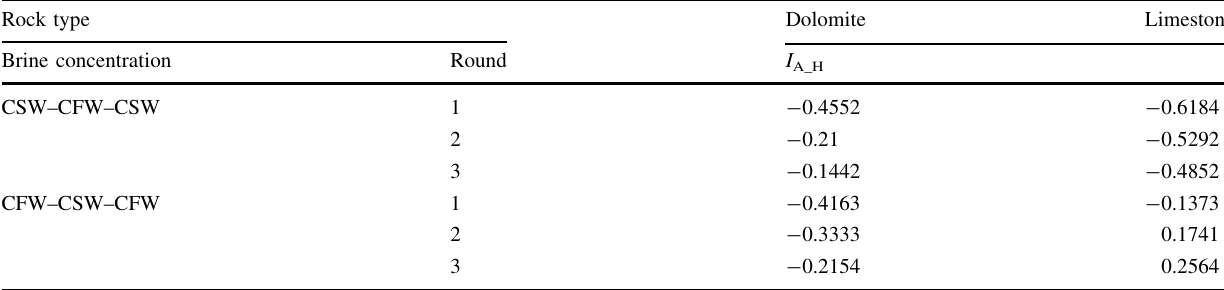
Table 4 Evaluation of Amott–Harvey wettability index ( I A_H ) with carbonated water Rock type